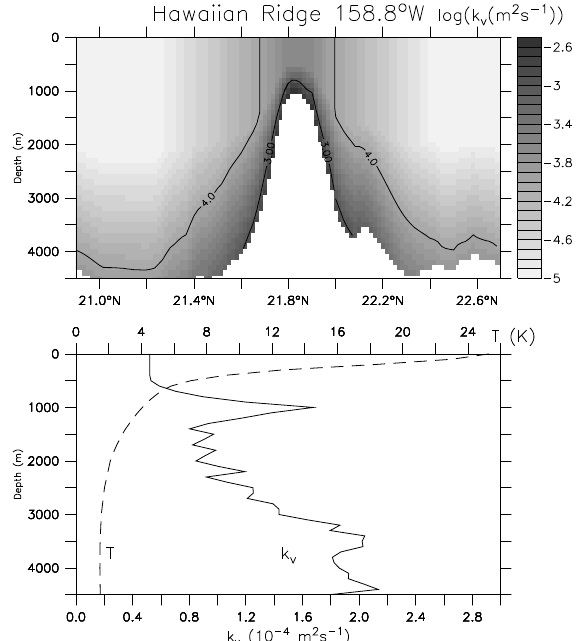
Fig. 7. Estimates of k v based on microstructure observations from the Hawaiian Ridge during the HOME experiment. Top: extrap- olation on a typical climate model grid box of 1.8 ◦ meridional width using Eq. (2) of Klymak et al. (2006) applied to a section at 158.8 ◦ W (Kauai Channel). A 1min grid for the bathymetry and a vertical resolution of 100m is used. Solid lines show contours at 10 − 3 and 10 − 4 m 2 s − 1 . Bottom: horizontally averaged profiles of k v (solid) and climatological temperature (dashed; from WOA05, Locarnini et al., 2006) used to calculate heat